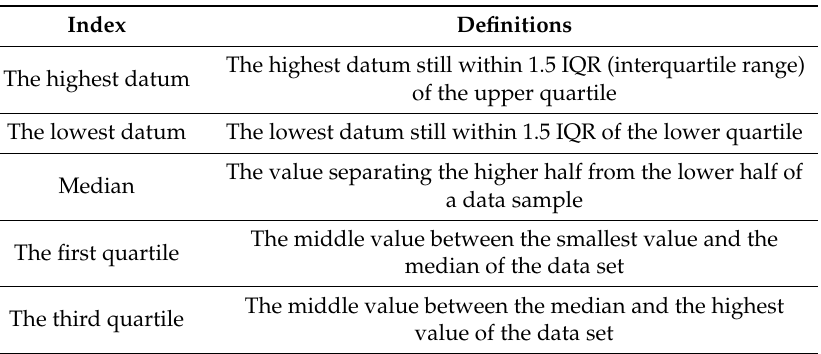
Table 4. Indicators of the box plots.